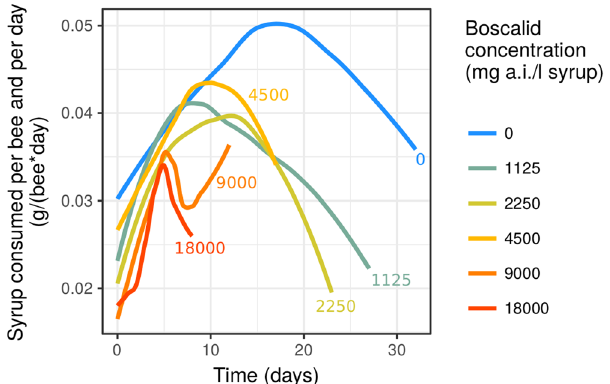
Figure 2. Daily syrup consumption over time until 50% mortality is reached in each cage. The lines for each boscalid concentration are loess trends (locally weighted polynomial regression). See Suppl. Mat., Section 3.2.3 for detailed representation of observed consumption rates and statistical testing with a polynomial mixed model. The model show highly significant time x concentration and main concentration effects: the kinetics of consumption was different between treatments and the average consumption on a given day was also different.